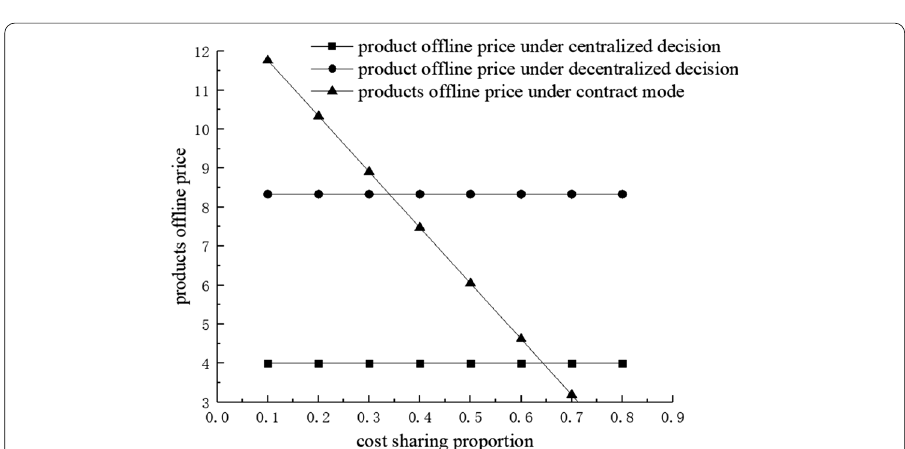
Fig. 6 Change of product offline price P 2 with cost share